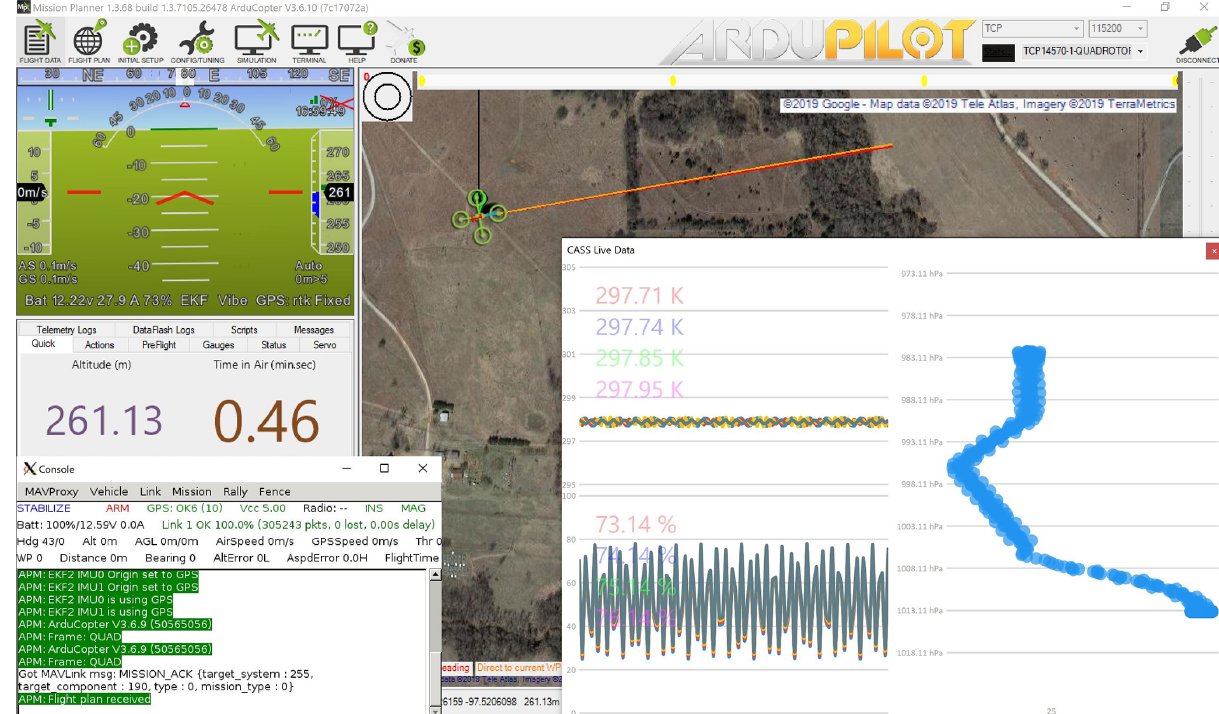
Figure 3. Screen capture of the simulator’s graphical user interface in which every flight parameter is displayed as if flying a real UAS. The UAS is represented by the green quadcopter in the map provided by Google (© 2019 Google – map data: © 2019 Tele Altas, Imagery © 2019 TerraMetrics); the heads-up display (HUD) in the top left corner shows the necessary avionics for the operator. The inset picture in the bottom right corner is a live view of the simulated temperature and humidity data interacting with the simulated UAS. Work is underway to better represent the vertical temperature and humidity profiles in the